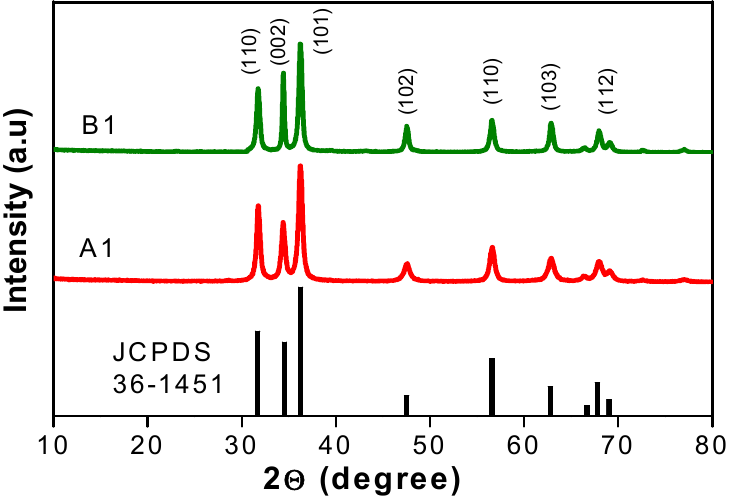
Figure 4. XRD pattern of A1 and B1 synthesized using S. persica leaf extract.